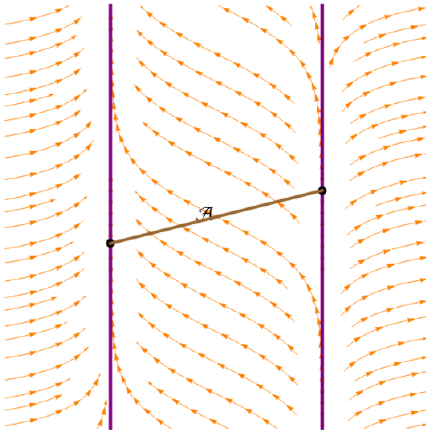
Figure 2 . The orange lines with arrows depict the trajectory of the modular (cid:13)ow in WCFT. Note that the modular (cid:13)ow can never pass through @ D , which is depicted by the two purple